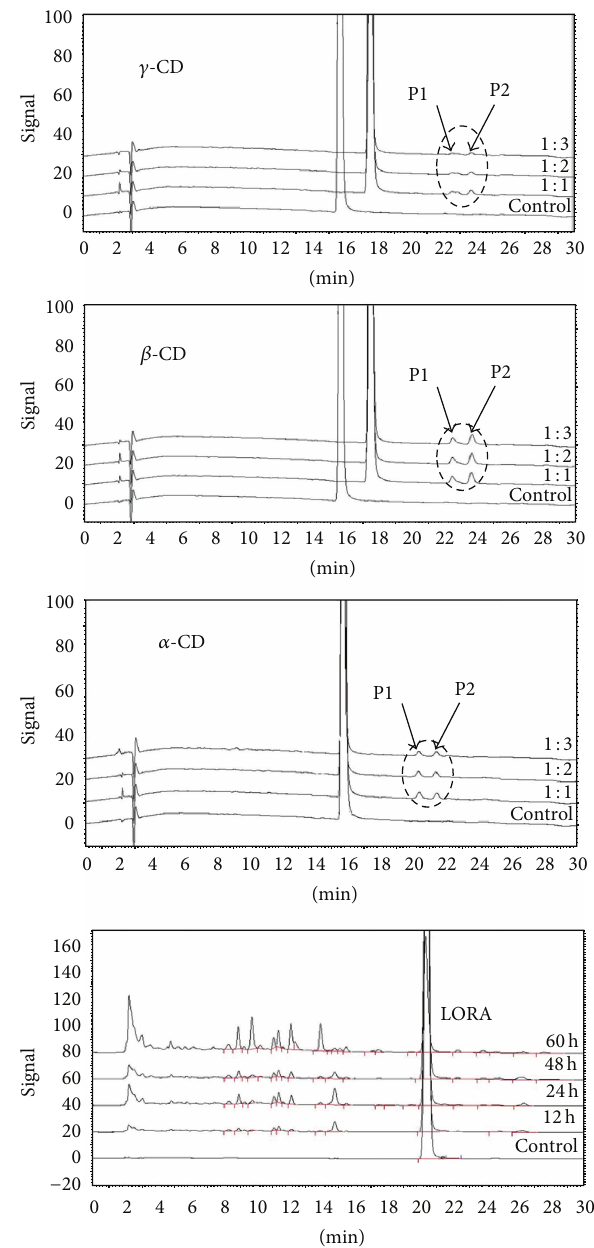
Figure 5: LORA chromatograms and complexes with 𝛼 -CD, 𝛽 -CD, and 𝛾 -CD, after irradiation. The photodegradation products (P1 and P2) for the binary complexes are